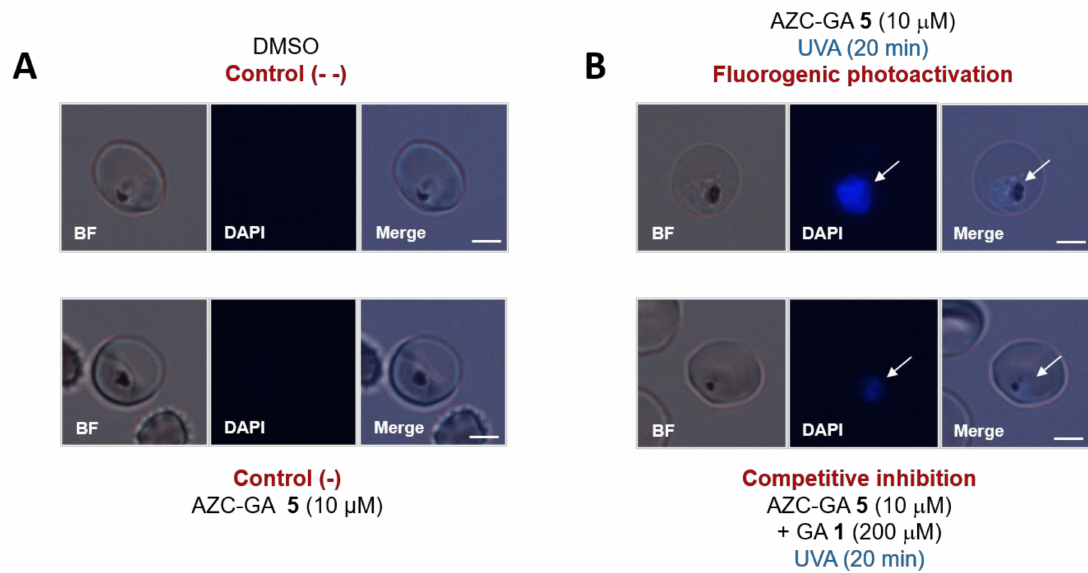
Figure 5. Photoalkylation of live 3D7 P. falciparum trophozoite blood-stages by AZC-GA 5 ± GA 1 . ( A ): Negative controls consisted of parasites treated with dimethyle sulfoxide (DMSO) or with non-photoactivated AZC-GA 5 . ( B ): Fluorogenic experiments consisted of parasites treated with photoactivated AZC-GA 5 in the absence or presence of excess GA 1 . Images were obtained on an Olympus BX60F-3 microscope using DAPI excitation channel ( λ EX = 359 nm). All UVA photoactivations were performed on ice (0–4 ◦ C) for 20 min. Fluorescence was recorded as seen with the naked eye. Images were taken using identical exposure times (132 ms) and are representative of several independent experiments ( n = 2–4, see Figure S1 in the Supplementary Materials). White arrows indicate the parasites. Scale bars represent 2 µ